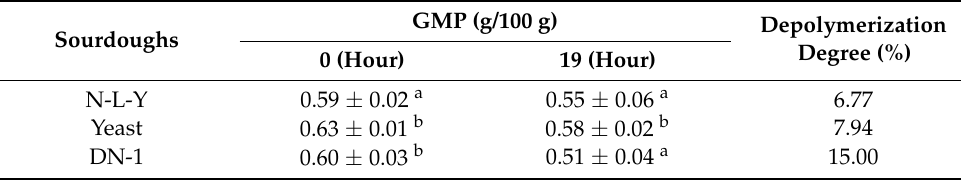
Table 1. GMP content and depolymerization degree in different fermented doughs.